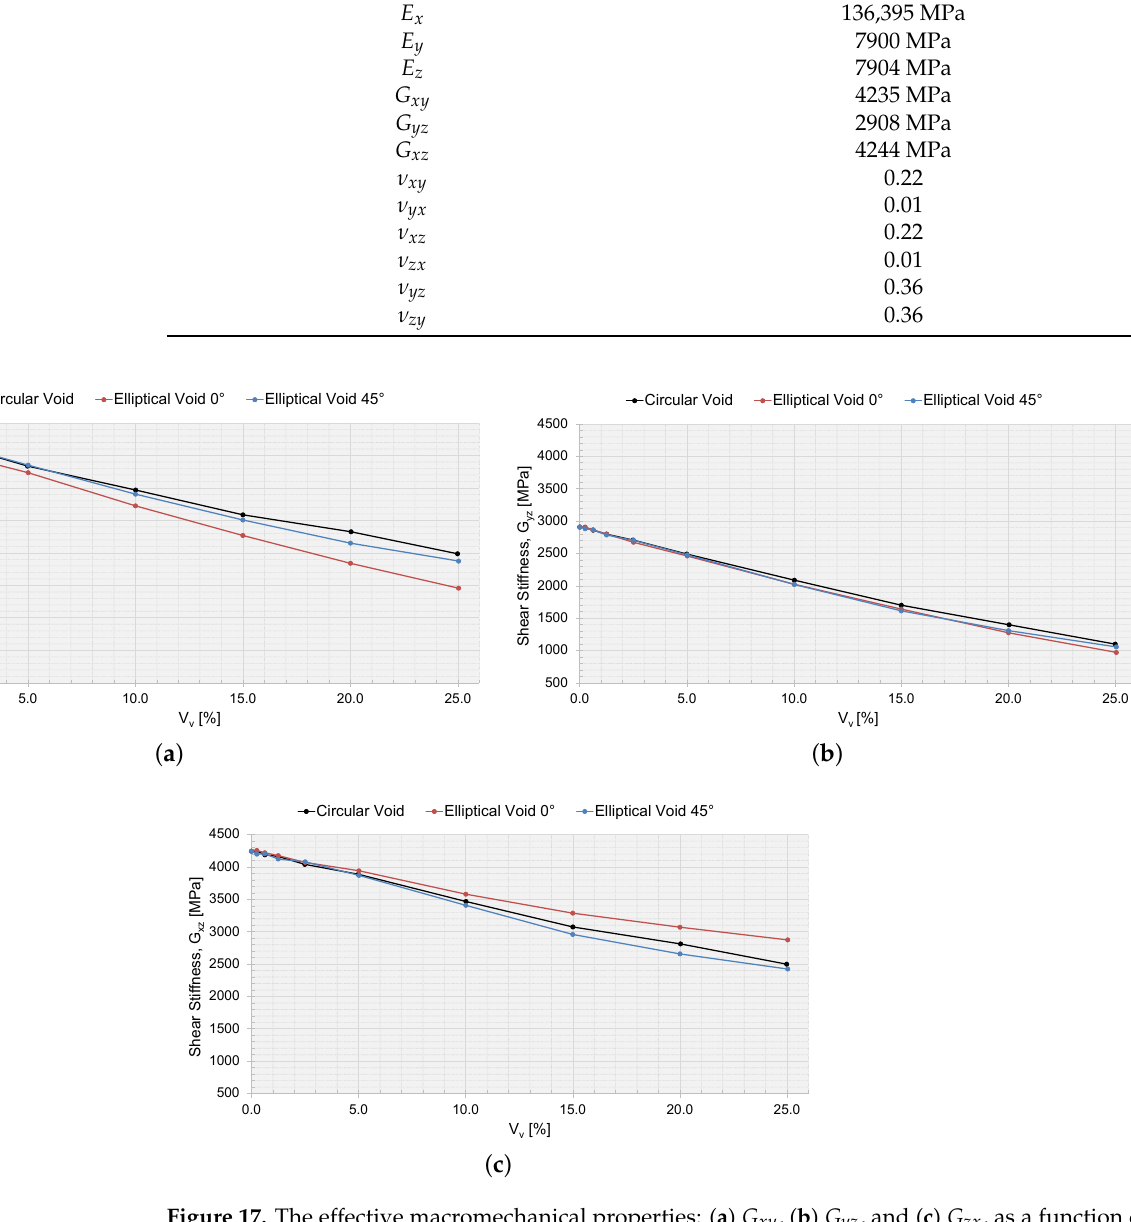
Figure 17. The effective macromechanical properties: ( a ) G xy , ( b ) G yz , and ( c ) G zx , as a function of void area, V v , for a 200 µ m